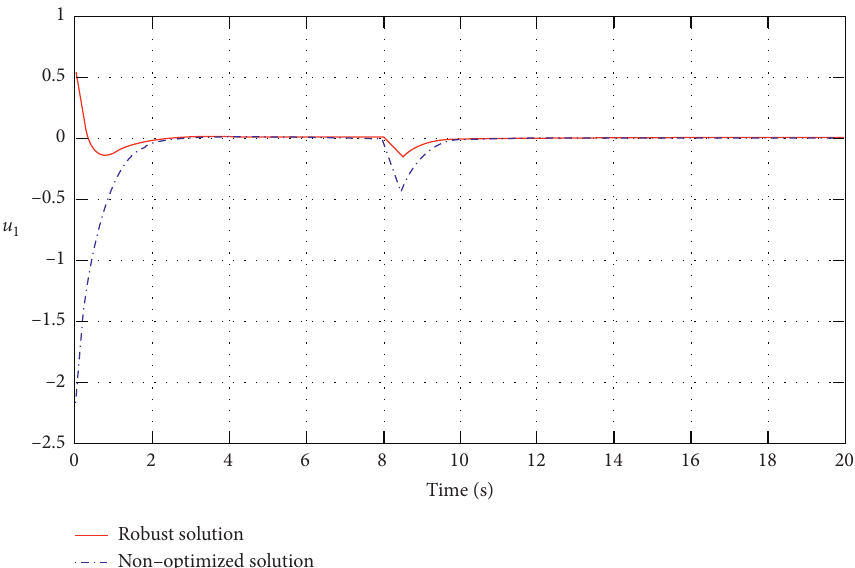
Figure 5: Comparison of u